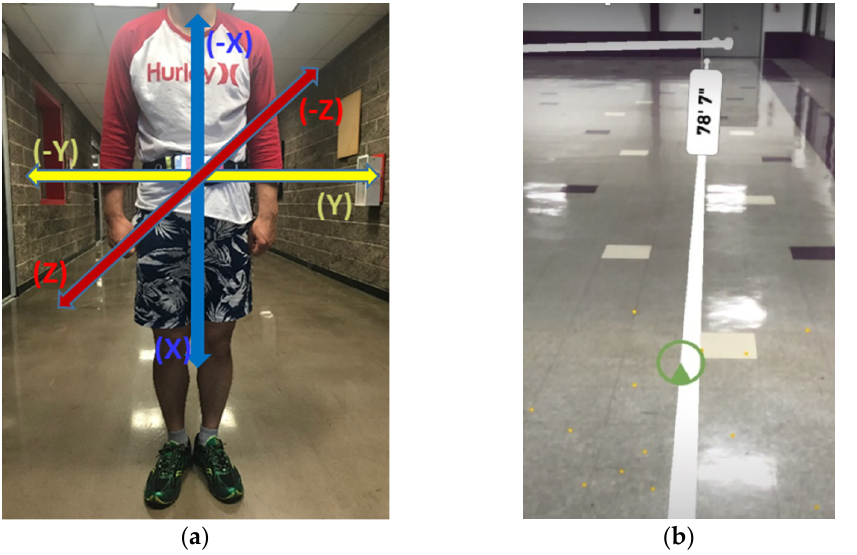
Figure 2. X-Y, and Z-axis orientations of the smartphone during the walking balance test. X-axis is the right ( − ) and the left (+) side of the participant. Y-axis is the upward ( − ) and the downward (+) of the participant. Z-axis is the forward (+) and the backward ( − ) of the participant. The participants wearing the smartphone with the mHealth application walk about a total of 157 feet. ( a ) A participant wearing a smartphone; ( b ) Indoor physical education (PE) room.